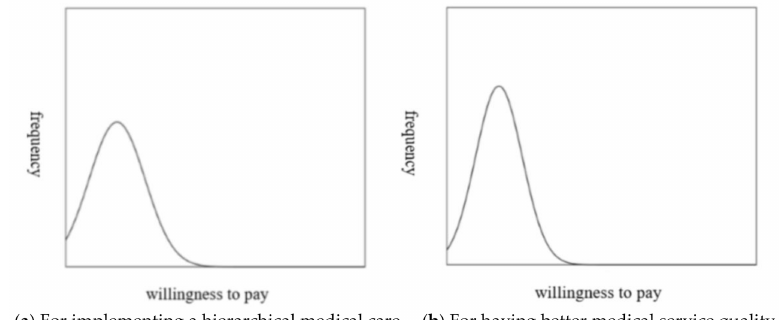
Figure 3. The distribution pattern of the WTP for outpatient copayment.